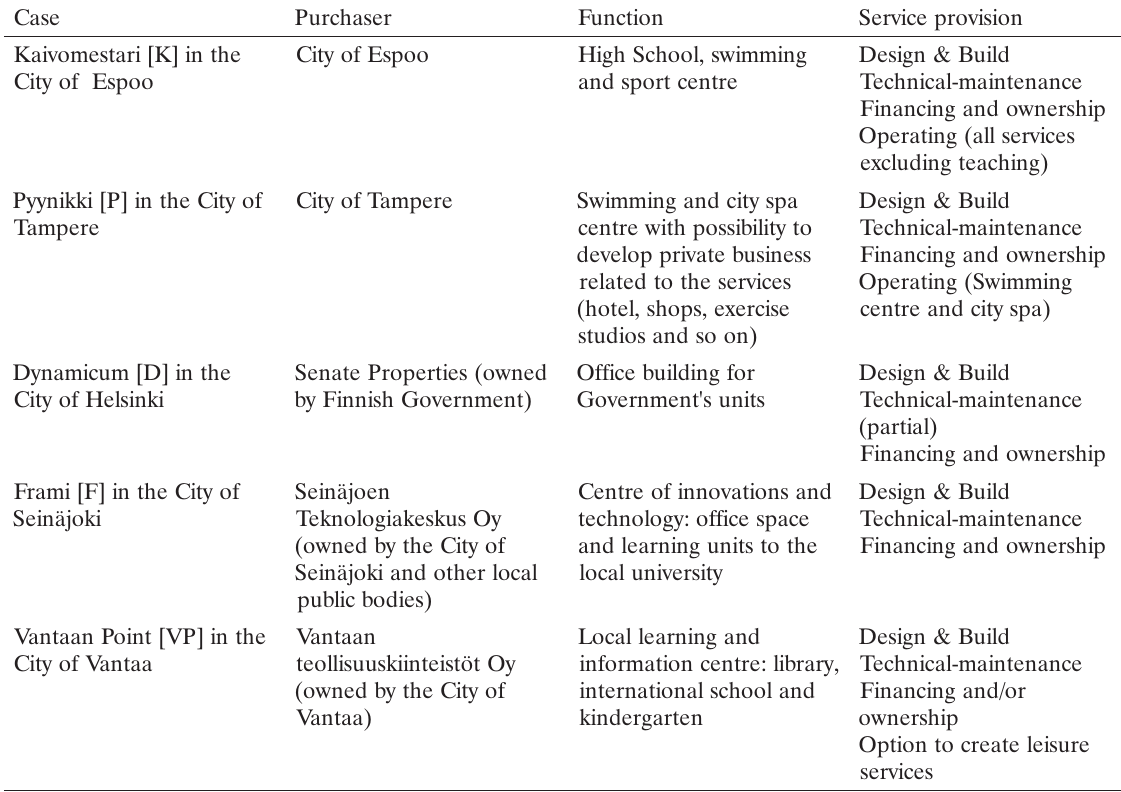
Table 1. Basic information of selected PPP